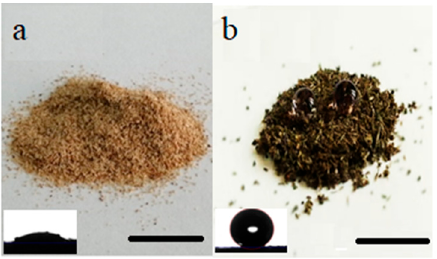
Figure 5. Photographs of ( a ) raw sawdust; ( b ) SMSD. Scale bar, 1 cm.